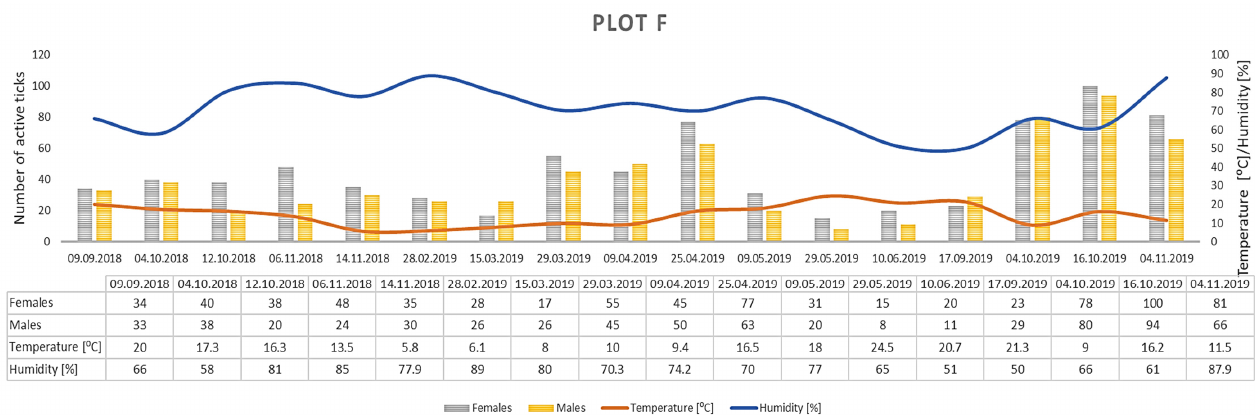
Figure 7. Abundance and seasonal activity of Dermacentor reticulatus adults in research plot E and weather conditions prevailing during tick collection. Predominance of active ticks in spring.